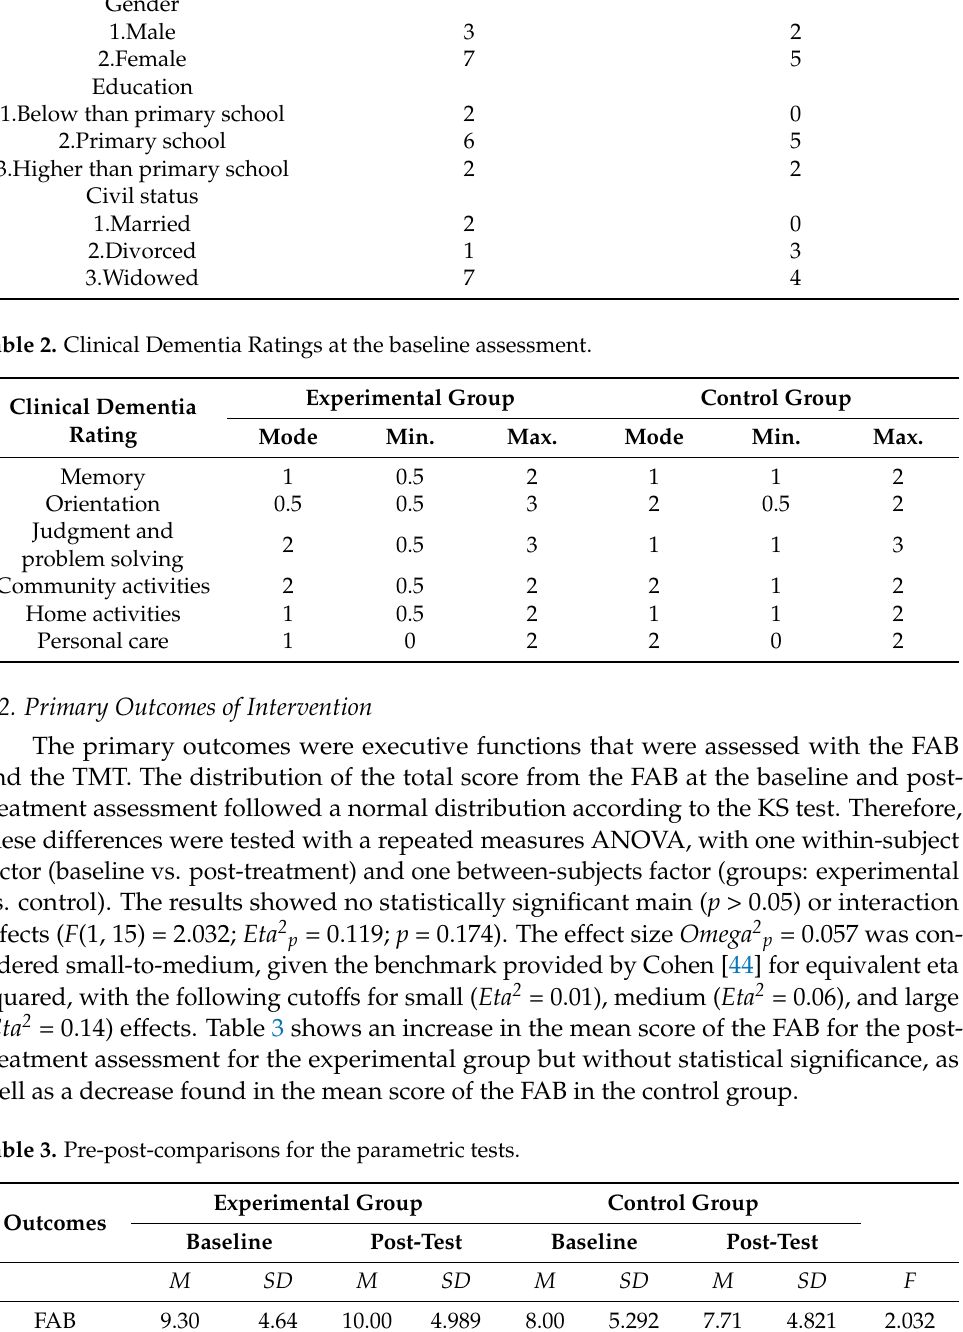
Table 1. Distribution of the sociodemographic variables for the experimental and control groups. Sociodemographic Variables